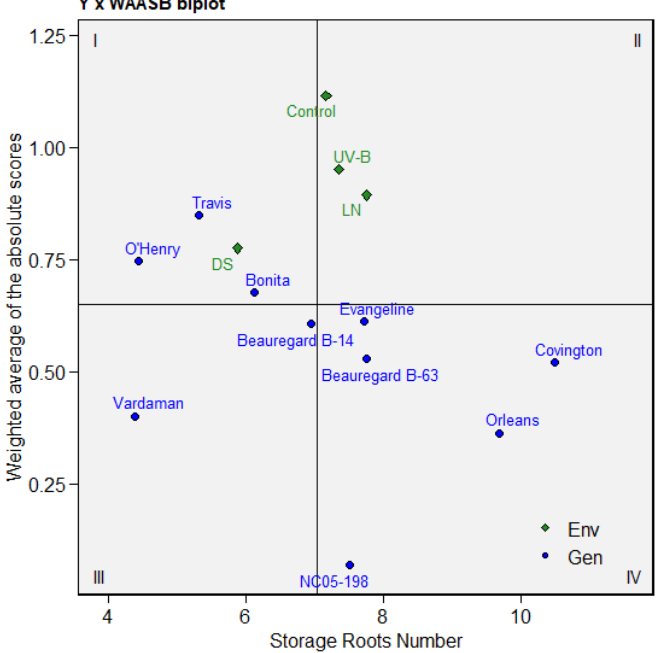
Figure 7. The yield × weighted average of absolute scores (WAASB) biplot based on joint interpretation of storage root number (Y) and stability (WAASB) for ten sweetpotato cultivars evaluated under drought (DS), ultraviolet-B (UV-B), low-nitrogen (LN), and control treatments.